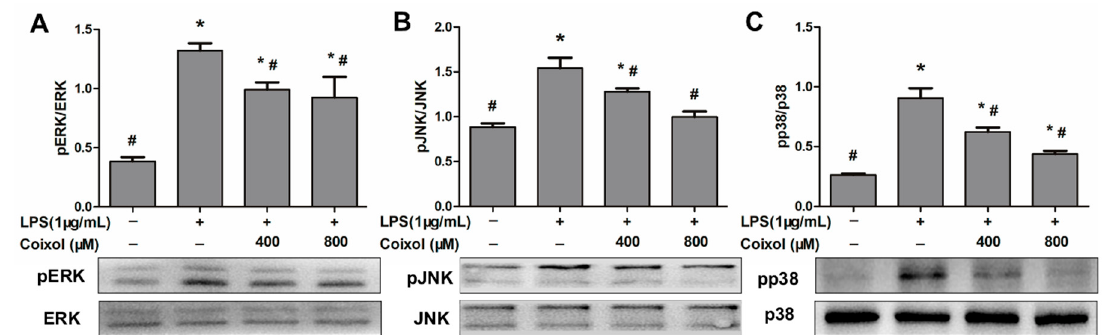
Figure 5. Effects of coixol on the activation of MAPK signaling in LPS-induced RAW 264.7 cells. Cells were pretreated with coixol for 4 h and then stimulated with 1 μ g/mL LPS for 4 h. The protein levels of ( A ) phospho (p) ERK , ( B ) pJNK and ( C ) pp38. Protein levels were measured by western blotting. ERK, JNK, and p38 were used as internal control. The data represent the mean ± SD ( n = 3). * p < 0.05 vs. control group. # p < 0.05 vs. LPS group.